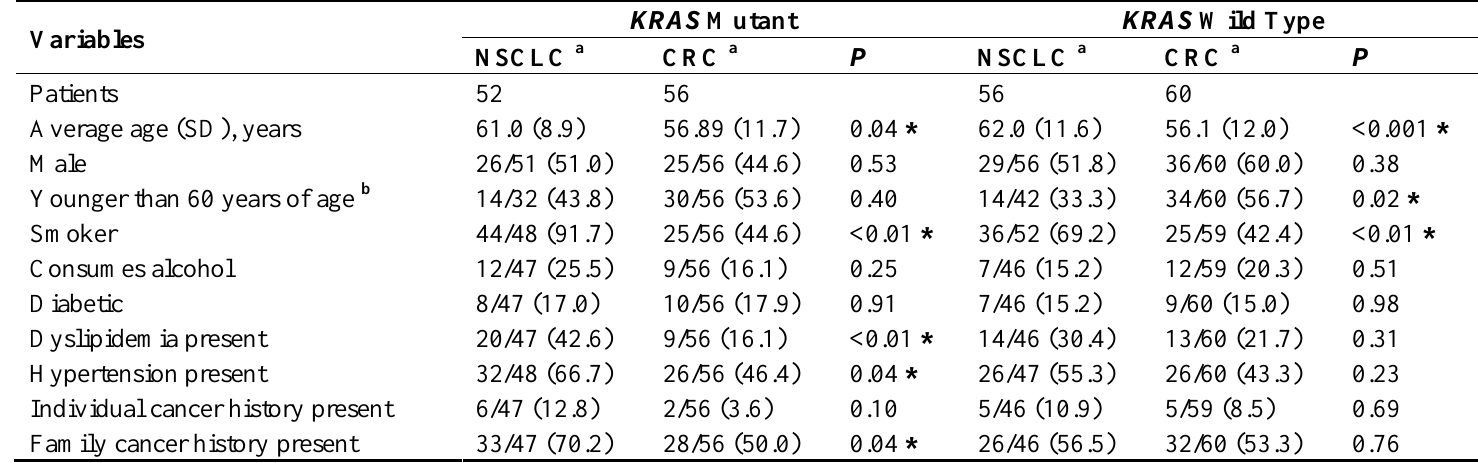
Table 3. Clinical and metabolic parameters in non-small cell lung carcinoma (NSCLC) and colorectal cancer (CRC) patients with the same KRAS mutational